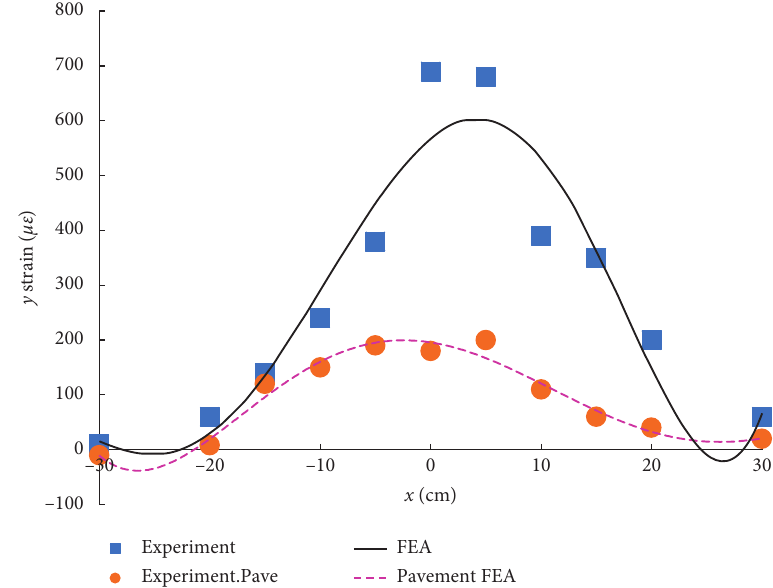
Figure 20: The strain at the top surface ( Y � +15cm) of the U-shaped stiffening rib-side plate.